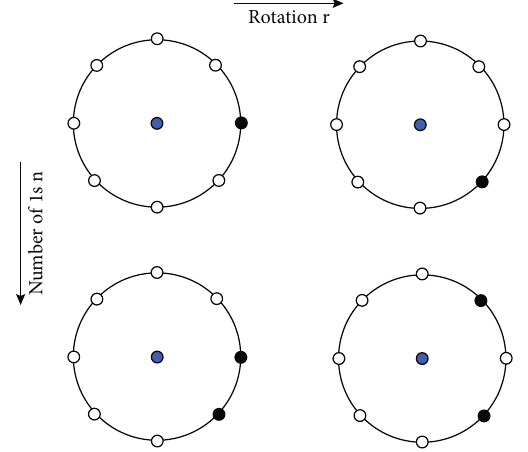
Figure 4: Four modes of color pixel collection points of ceramic materials after dimensionality reduction using dynamic equivalent mode.